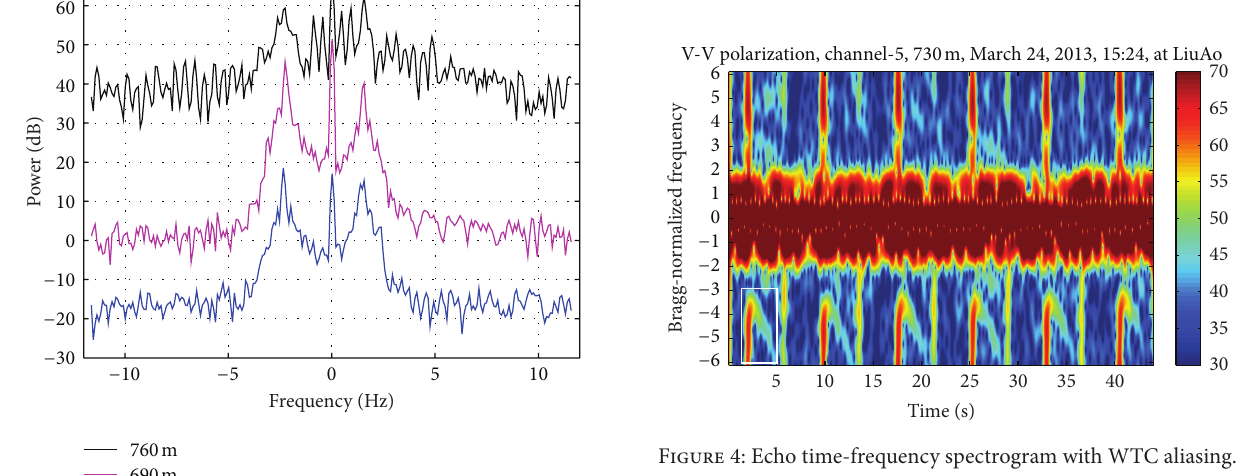
Figure 3: Echo time-frequency spectrogram with no WTC aliasing.